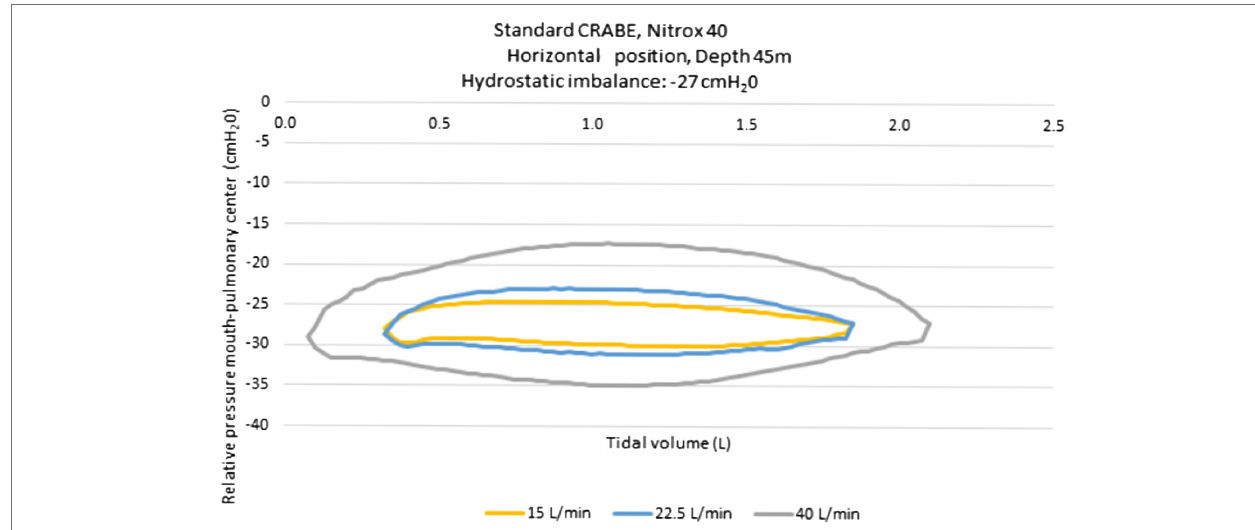
FIGURE 2 | Pressure-volume loops obtained with the standard CRABE rebreather on a ventilatory simulator, at a 45-meter depth under three ventilatory flow